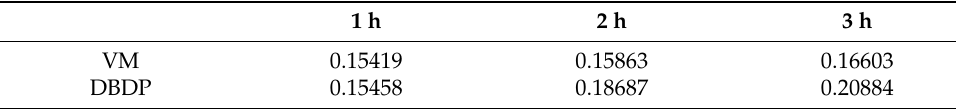
Table 2. FWHM of Al 2 O 3 powder after different milling times.